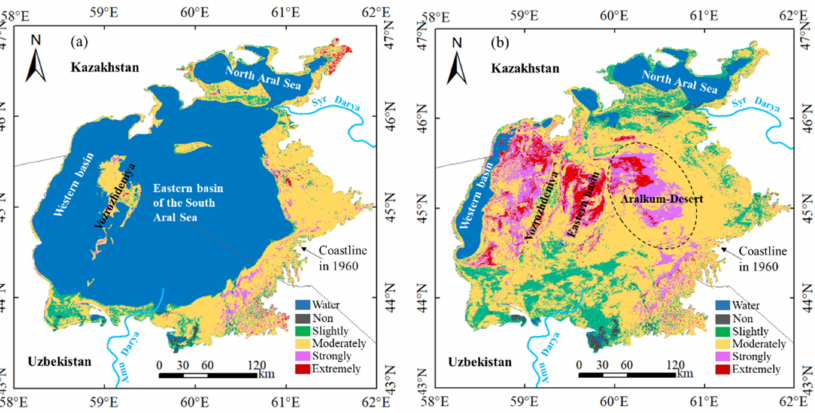
Figure 7. The distribution of soil salinity (EC) on the exposed seafloor in 1986 ( a ) and 2020 ( b